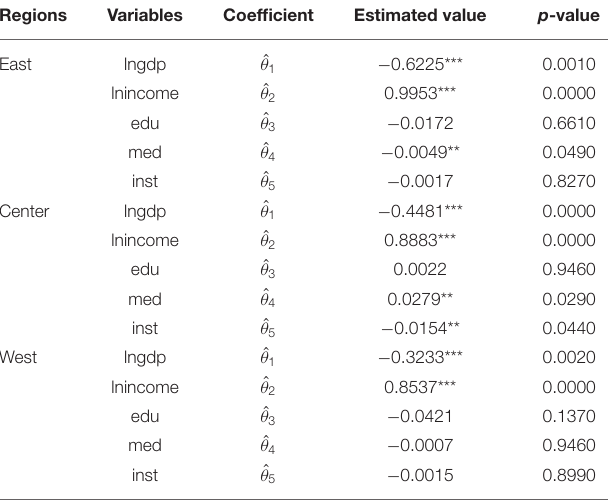
TABLE 5 | Estimated coefficients of the control